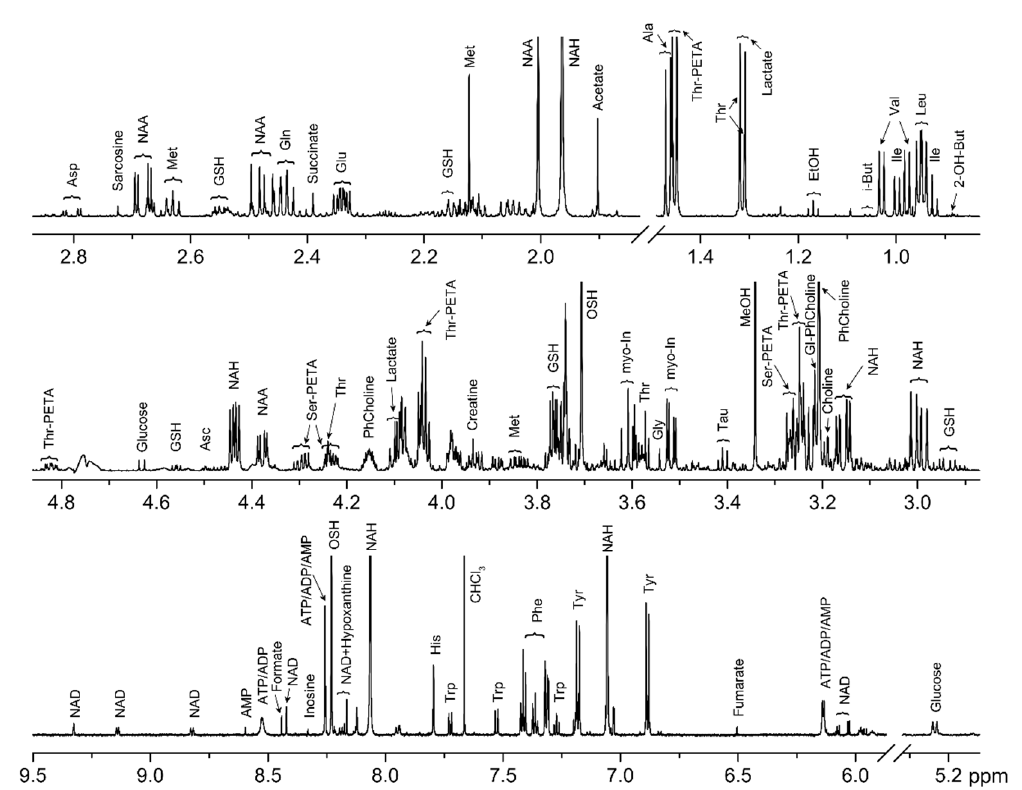
Figure 1. Representative 1 H NMR spectra of protein-free lipid-free extract from S. lucioperca lens with